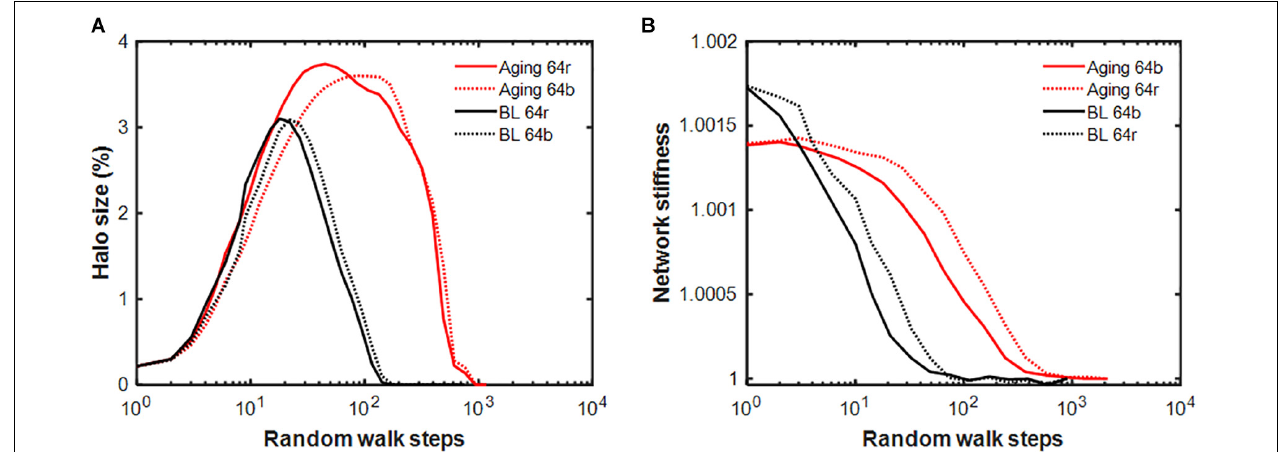
FIGURE 8 | Comparison of the dynamics of network properties in the baseline and the aging models following an initial injury of setting a single spring constant to a value twice the fixed point. (A) Evolution of the halo size relative to the size of the network given in percent for the stiffness-biased (b: solid lines) and pure random (r: dotted lines) walks for the baseline (BL, black) and aging (red) models. (B) Relaxation of network stiffness normalized to the value after the injury has been removed. Notice that the magnitude of the network stiffness barely increases beyond the equilibrium value because less than 4% of the network members are affected by the